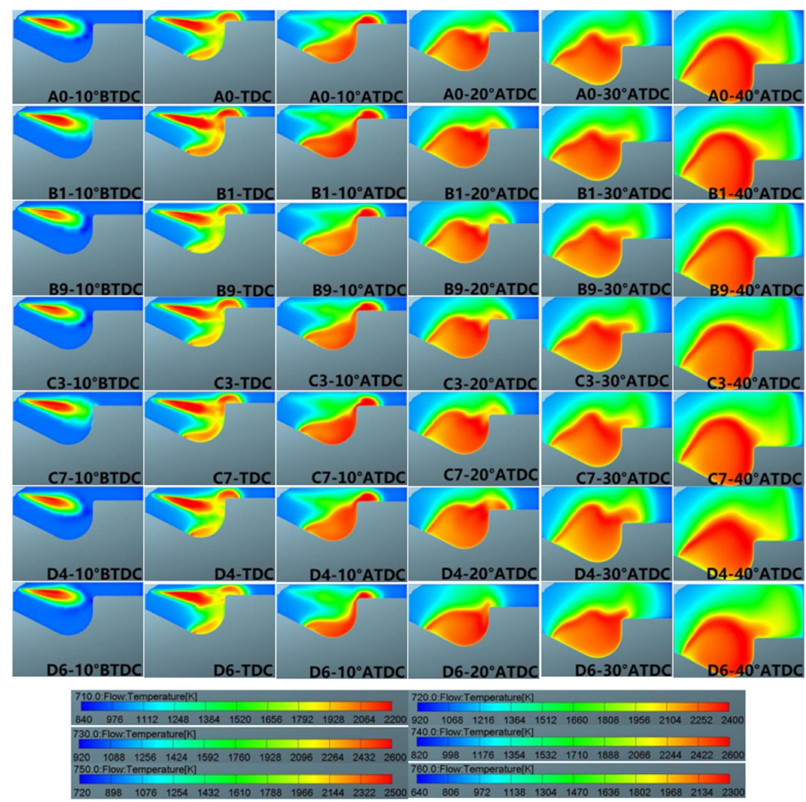
Figure 42. In-cylinder combustion temperature.